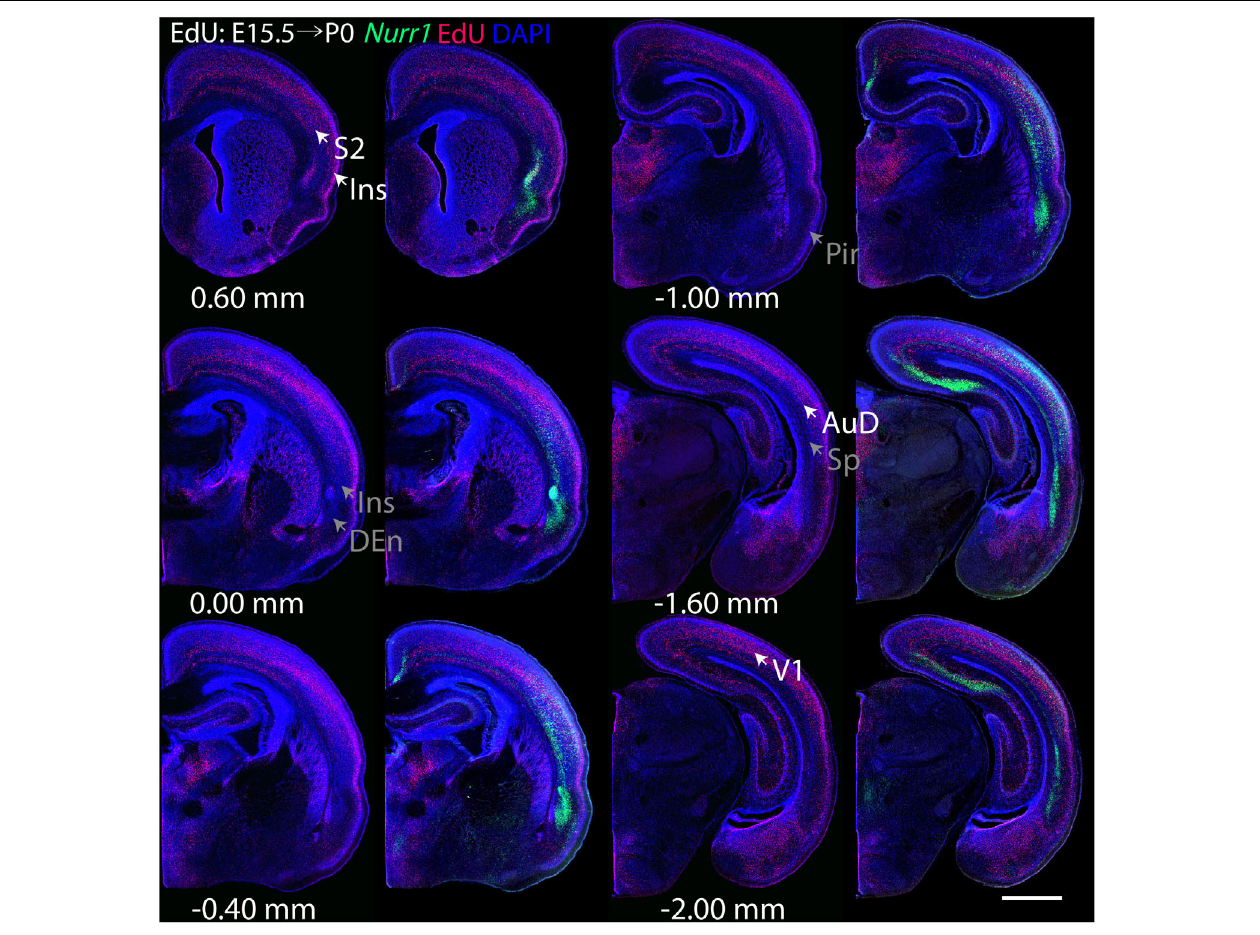
FIGURE 7 | Overview of EdU labeling on E15.5 with Nurr1 FISH on P0. White arrows indicate the EdU labeled regions. Gray arrows indicate the regions with reduced EdU labeling. S2, secondary somatosensory cortex, AuD secondary auditory cortex, V1 primary visual cortex dorsal area, DEn, dorsal endopiriform nucleus, Ins, insular cortex, Pir, piriform cortex, Sp, subplate. Numbers below sections indicate the bregma coordinate. N = 3 rats. Scale bar = 1